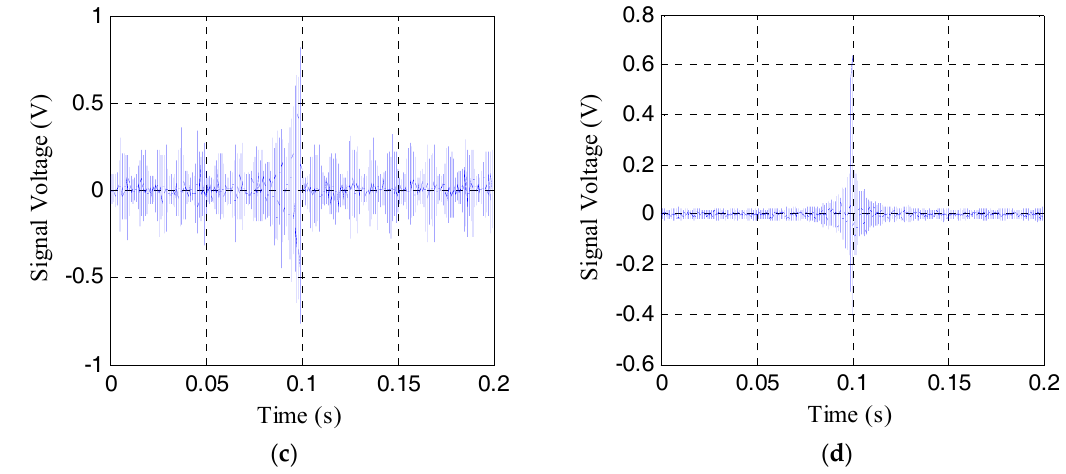
Figure 8. Four different signals in time reverse method at the pre-load of 3 MPa. ( a ) The emitted signal; ( b ) the received signal; ( c ) the reversed signal; ( d ) the focused signal.